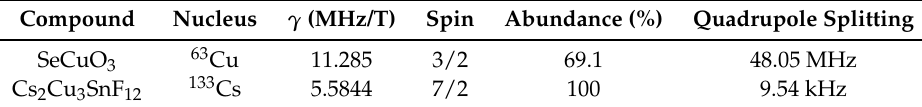
Table 2. NMR properties of the nuclei used in